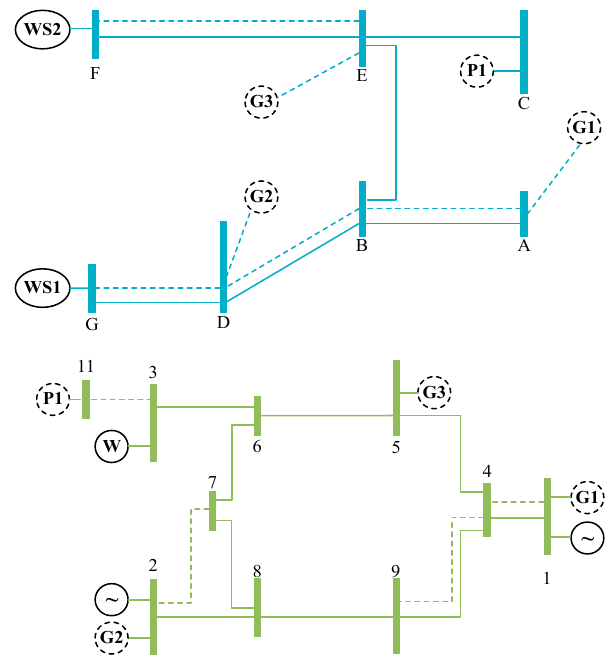
Figure 4. Planning grid under scenario 2. The operation cost for each hour in a typical load day was calculated by the proposed immune evolution method. The convergence trends are very close. Therefore, in order to give a clear picture, only the immune evolution curves at 12:00 and 00:00 were selected and drawn in Figure 5 to validate the convergence characteristics of the algorithm. It can be seen that the immune algorithm had good convergence characteristics in terms of unit output optimization. The correctness of the algorithm parameters was also validated.